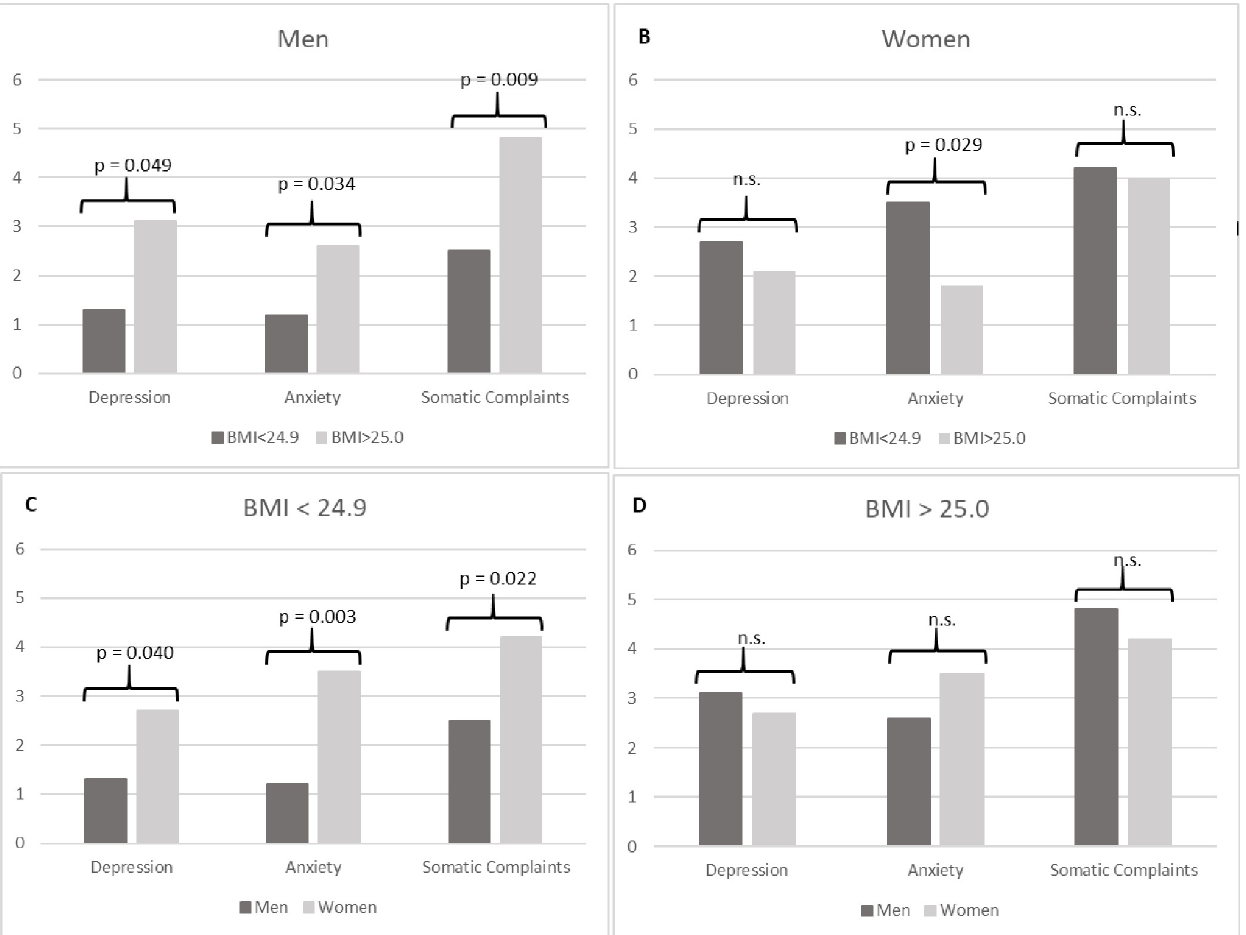
Fig 1. Symptoms of depression, anxiety and somatic complaints in relation to gender and body mass index. Note: A–male participants with or without excess weight; B–female participants with or without excess weight; C–participants without excess weight (women vs. men); D–participants with excess weight (women vs.